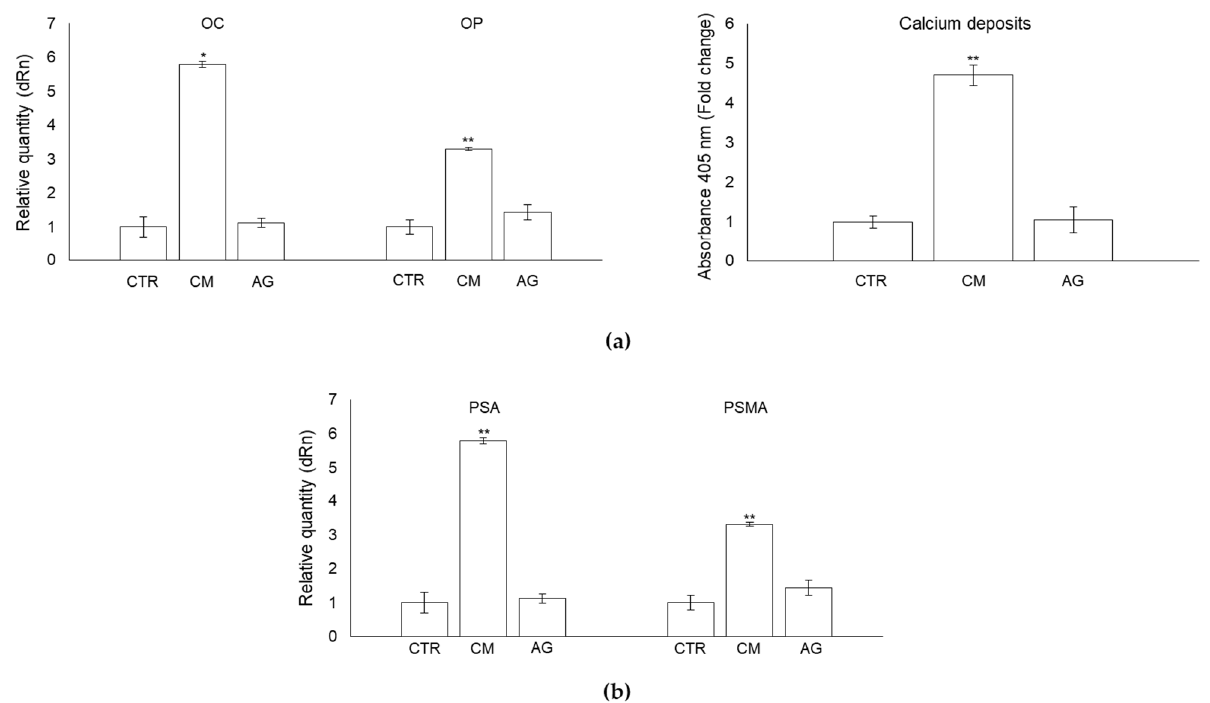
Figure 10. Methylglyoxal (MG)-derived 5-hydro-5-methylimidazolone (MG-H1) is a novel paracrine factor released by bone metastasis-derived PC3 cells to alter human osteoblasts (OB) mineralization and induce a prostate-specific phenotype. ( a ) expression of bone mineralization-participating proteins osteocalcin (OC) and osteopontin (OP) and calcium deposits formation, ( b ) mRNA expression of prostate-specific antigen (PSA) and prostate-specific membrane antigen (PSMA) evaluated in OB exposed for 24 h to conditioned medium (CM) from PC3 cells and to CM from PC3 pre-treated (6 h) with the specific MG scavenger aminoguanidine (AG) (1 mM). Control cells (CTR) represent OB cultured for the same period of time in their specific growth medium. Transcript levels were evaluated by real-time PCR while calcium deposits were measured by the alizarin red staining method. The histogram indicates the mean ± SD of three different cultures, and each was tested in duplicate. * p < 0.05, ** p < 0.01, versus CTR and AG.